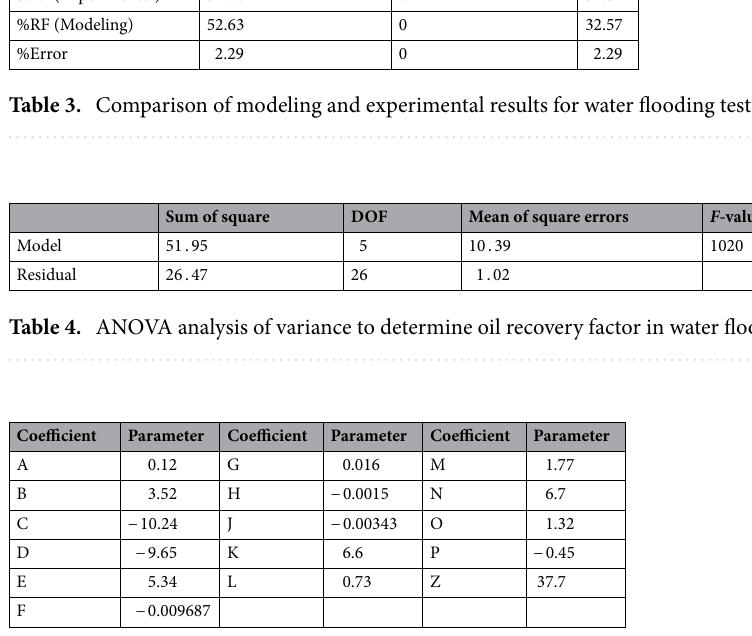
Table 5. Coefficients of the proposed model using design